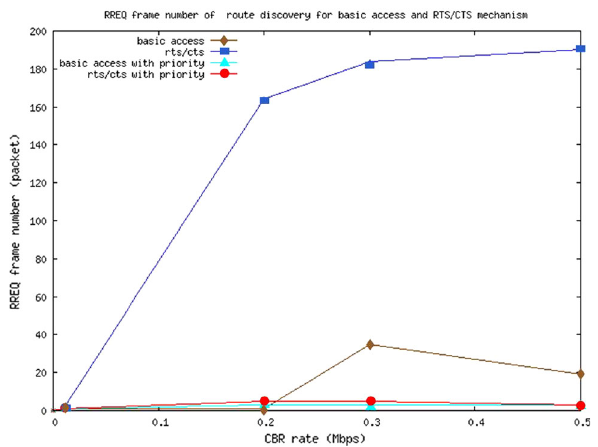
Fig. 7 RREQ packet number of route discovery in the 7-nodes chain topology